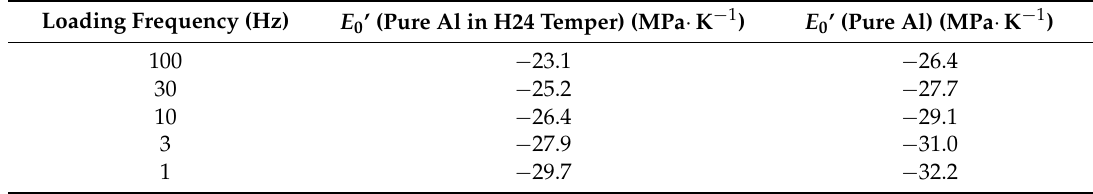
Table 1. Temperature softening coefficient E 0 ’, for pure Al in the H24 temper and for pure Al, as obtained from linear regression of dynamic-mechanical analyzer test